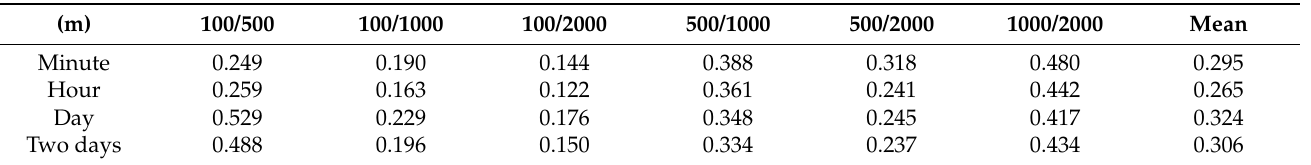
Table 9. Overall Kappa coefficients for results based on the same temporal scale and different spatial